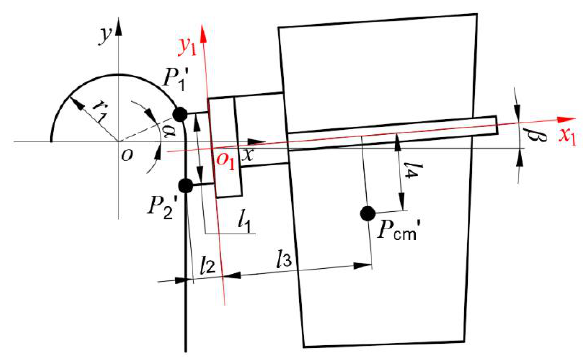
Figure 4. Schematic diagram of the manipulator’s position.